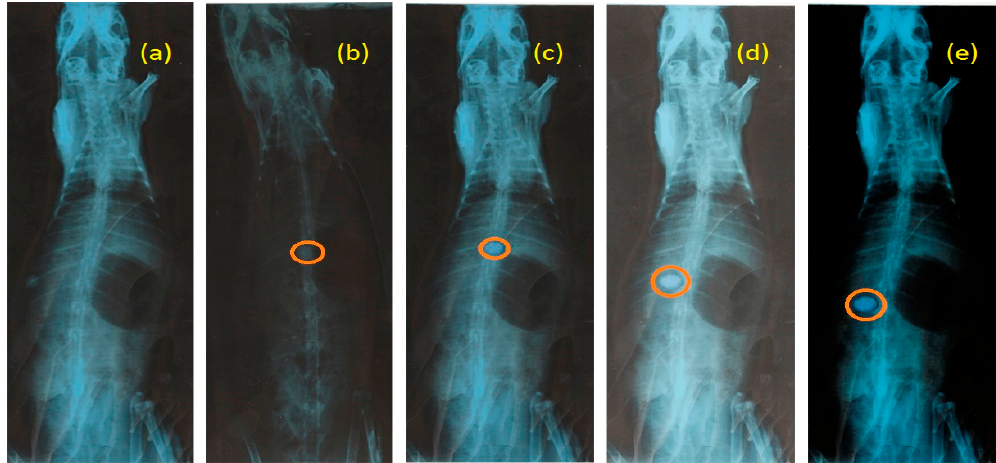
Figure 9. X-ray radiograms ( a ) Before administering RGM-6, ( b ), ( c ), ( d ) and ( e ) showing mucoadhesion of RGM-6 at 1 h, 2 h, 4 h, and 8 h respectively.